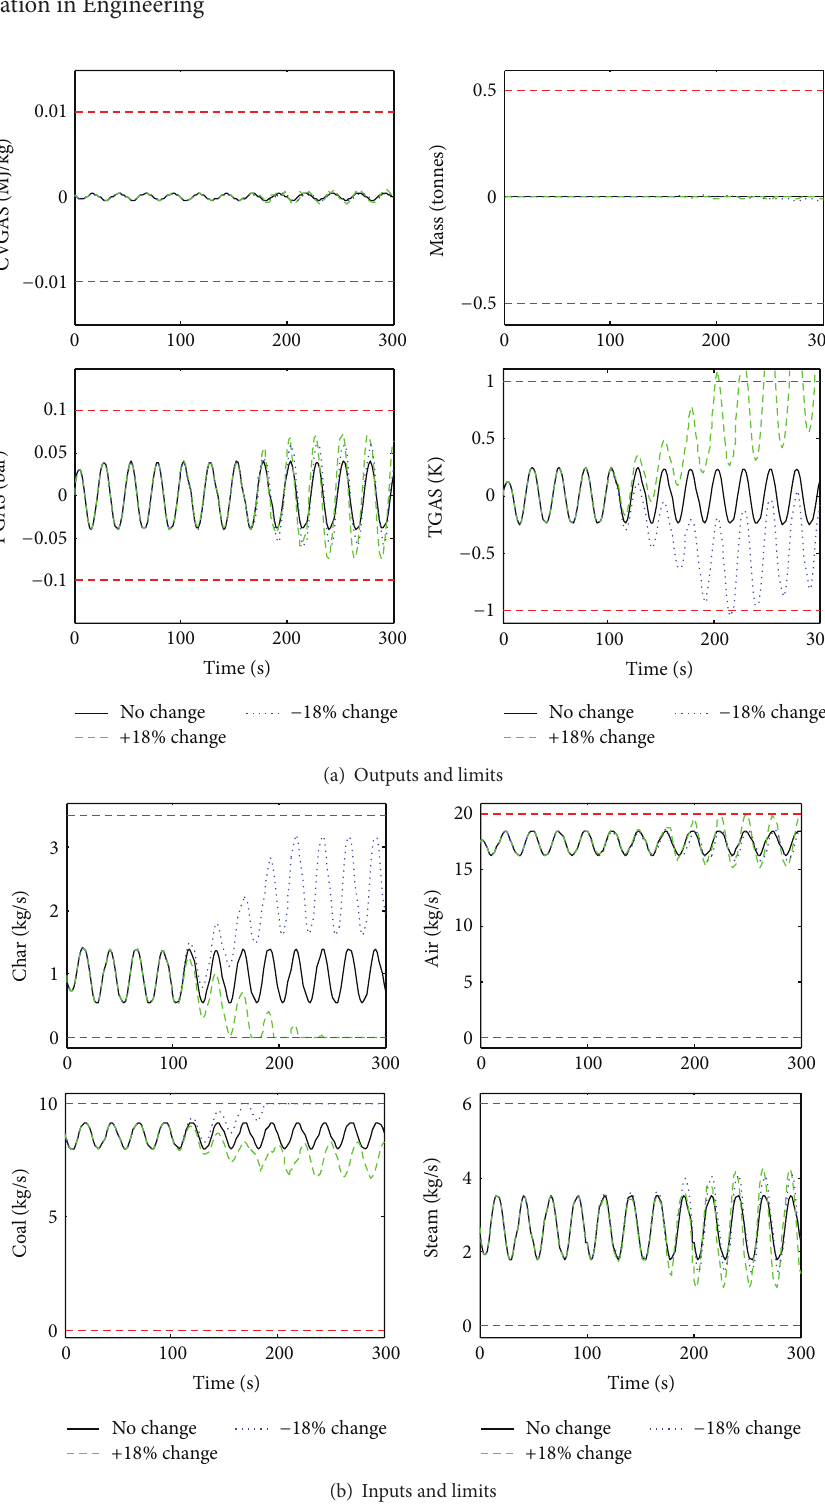
Figure 8: Response to sinusoidal disturbance at 100%